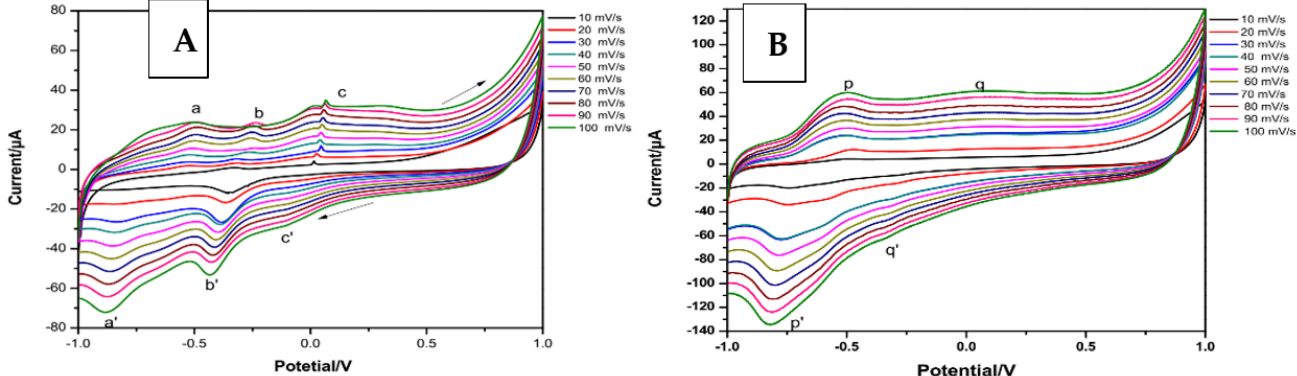
Figure 7. Cyclic voltammogram of SPCE/Cu-BPND ( A ), cyclic voltammogram of te SPCE/Ni-BPND ( B ), both obtained in a 0.1 M PBS (pH 7.0) at scan rates 10 to 100 mV/s vs.